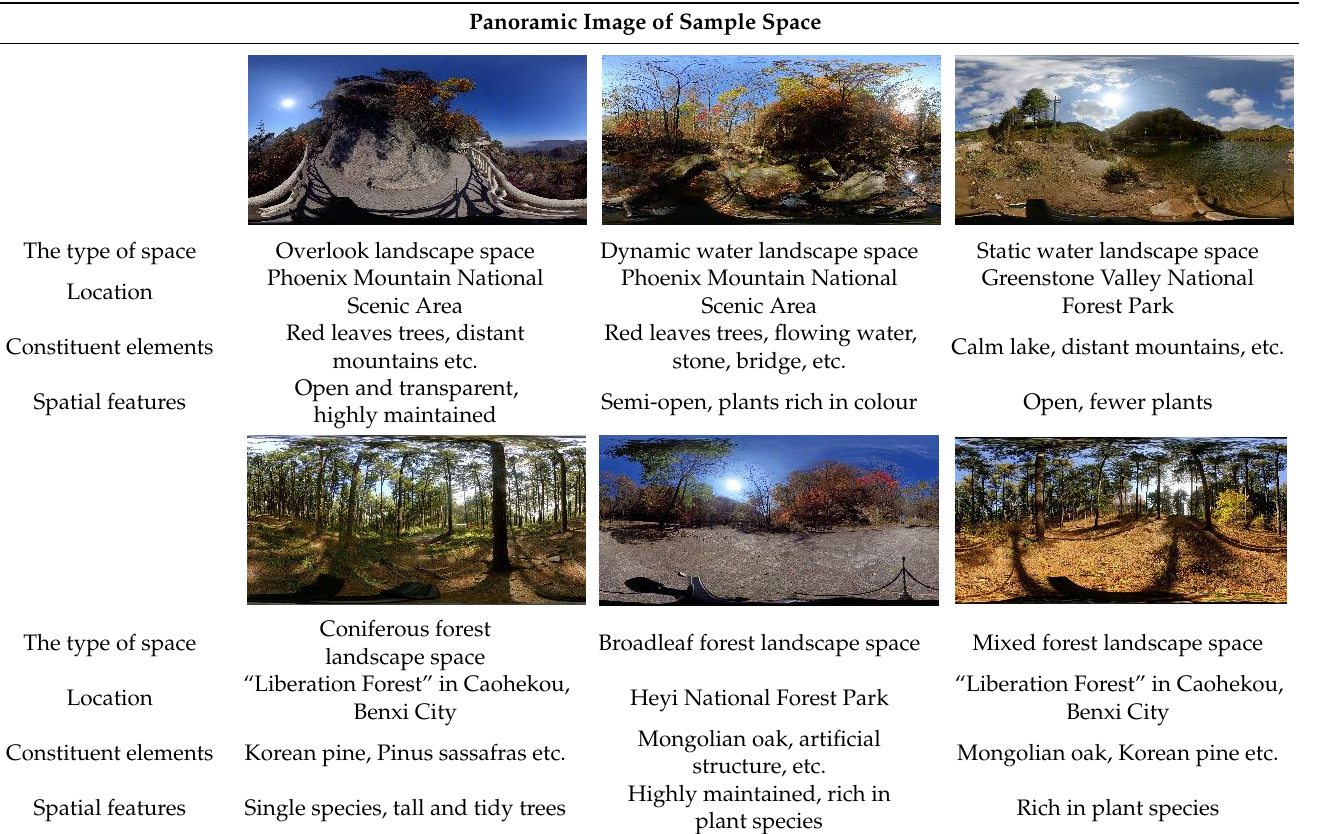
Table 1. The basic characteristics of the sample spaces.